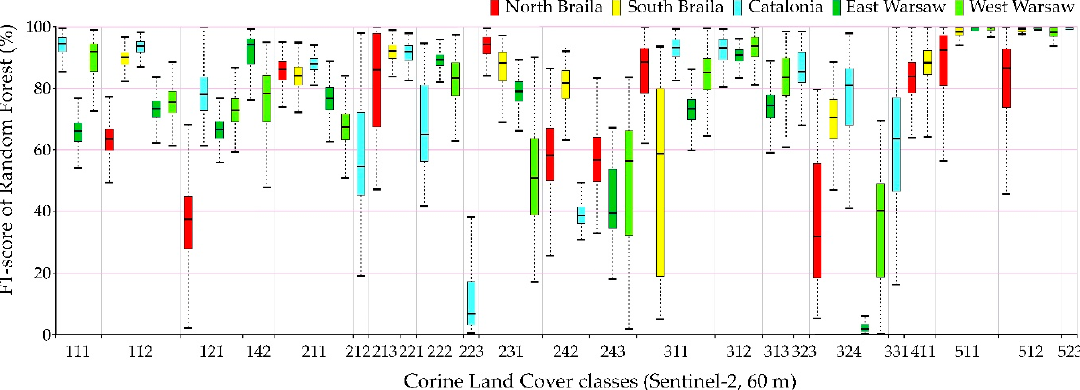
Figure 9. The best classification results (F1-score) achieved from the Support Vector Machine algorithm with the radial kernel function (SVM RBF) classifier and multitemporal Sentinel-2 images.